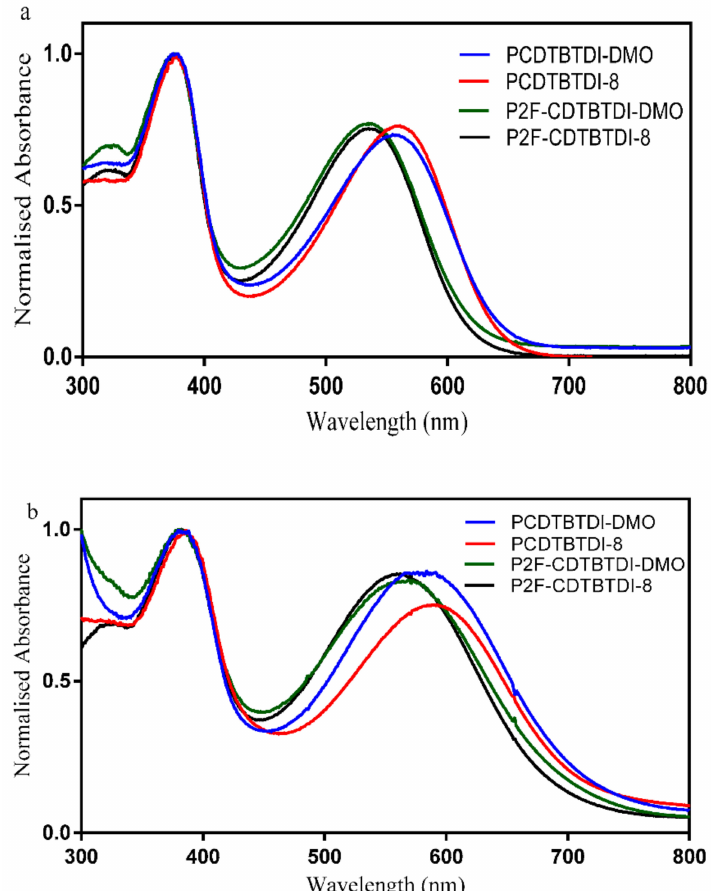
Figure 1. Normalized UV-vis absorption spectra of PCDTBTDI-DMO, PCDTBTDI-8, P2F-CDTBTDI- DMO and P2F-CDTBTDI-8 in ( a ) chloroform solutions; and ( b )